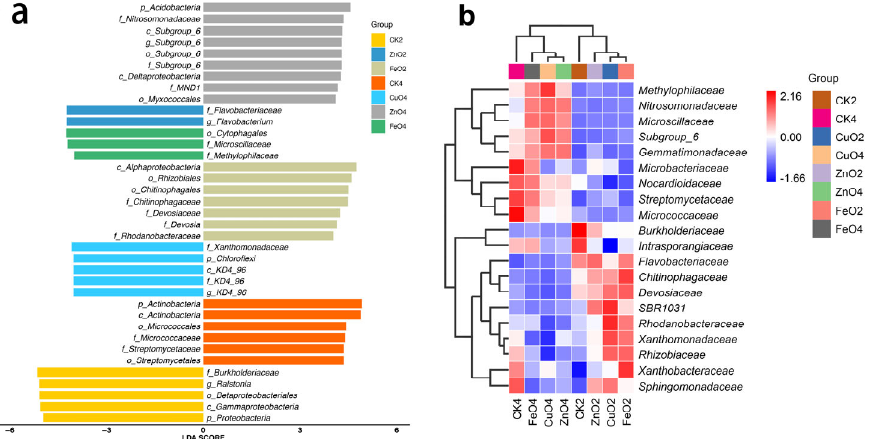
Figure 6. Linear discriminant analysis (LDA) effect size (Lefse) of the bacterial taxa ( a ), which identifies the most differentially abundant taxa among the different nanoparticles treatment. Only taxa with LDA values greater than 4 ( p < 0.05) are shown. Hierarchical clustering analysis and heat map at the ( b ) family level. The tree plot represents a clustering analysis of the top 20 bacteria at family levels according to their Pearson correlation coefficient matrix and relative abundance, the upper tree plot represents a clustering analysis of soil samples according to an euclidean distance of data. Abbreviation: 2nd week of nanoparticles treatment (CK2, CuO 2 , ZnO 2 , and FeO 2 ), 4th week of nanoparticles treatment (CK4, CuO 4 , ZnO 4 , and FeO 4 ).